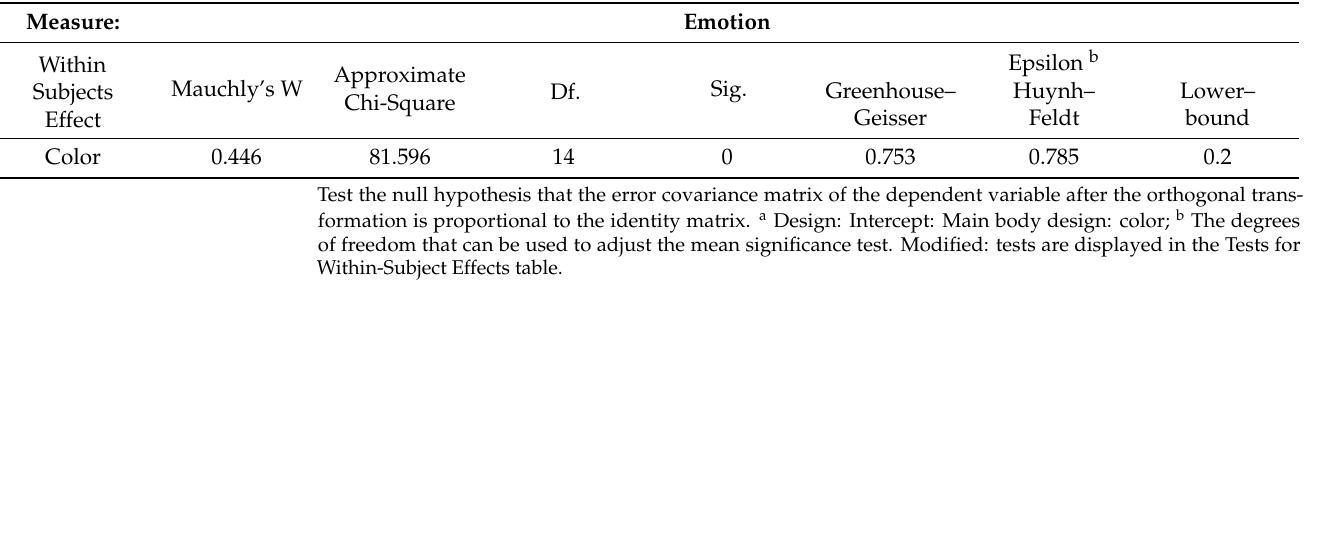
Table 5. Mauchly’s test of sphericity a